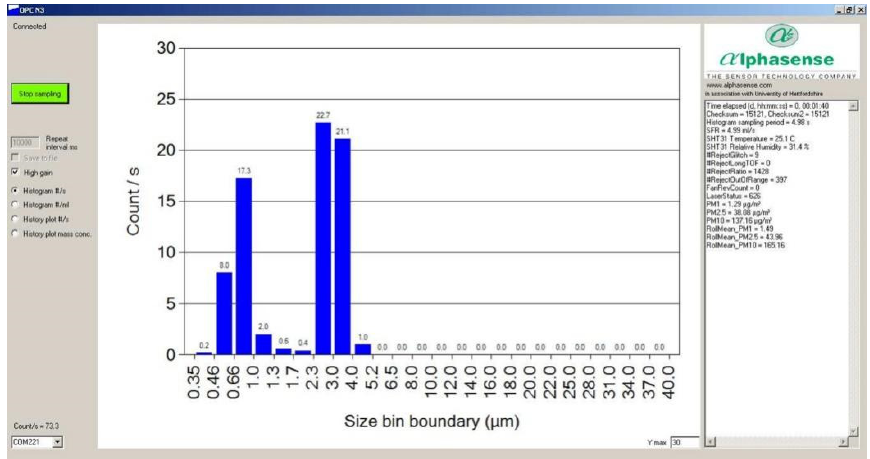
Figure 7. Calibration results for 0.75 and 3 μ m Polystyrene Latex standard particles by OPC ‐ N2.